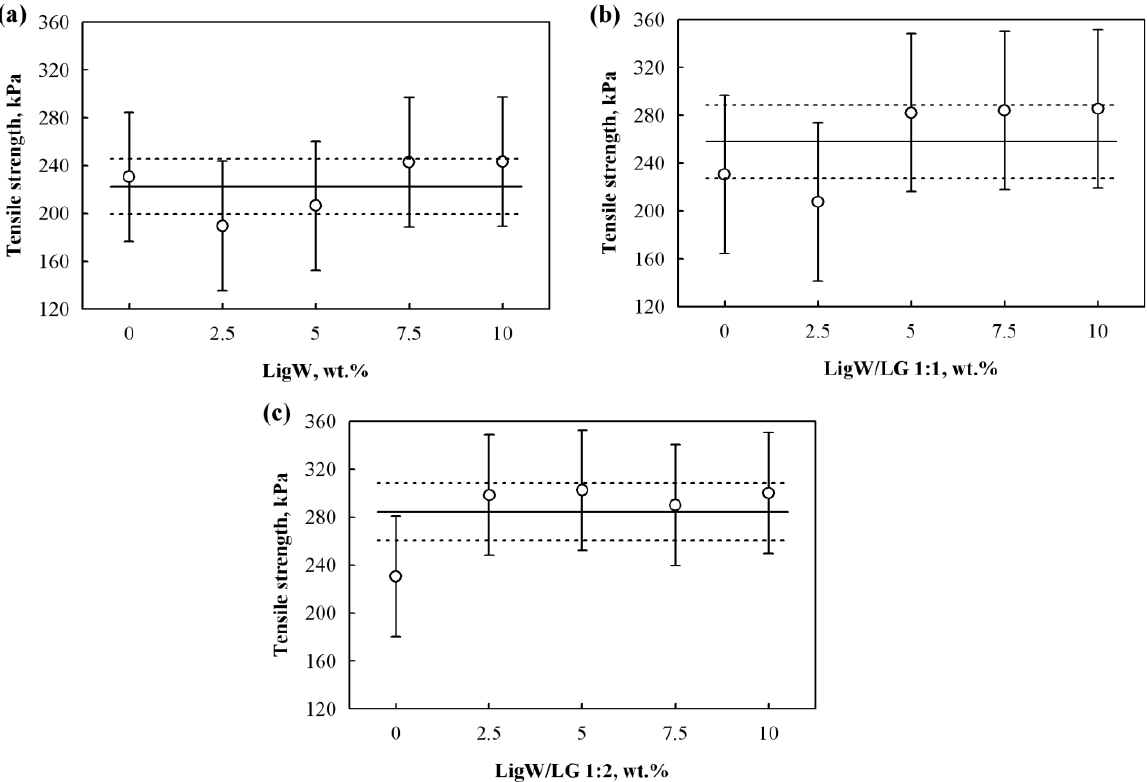
Figure 7. Tensile strength of bioPUR foams with: ( a ) LigW particles; ( b ) LigW/LG 1:1 particles; ( c ) LigW/LG 1:2 particles. ( c ) LigW/LG 1:2